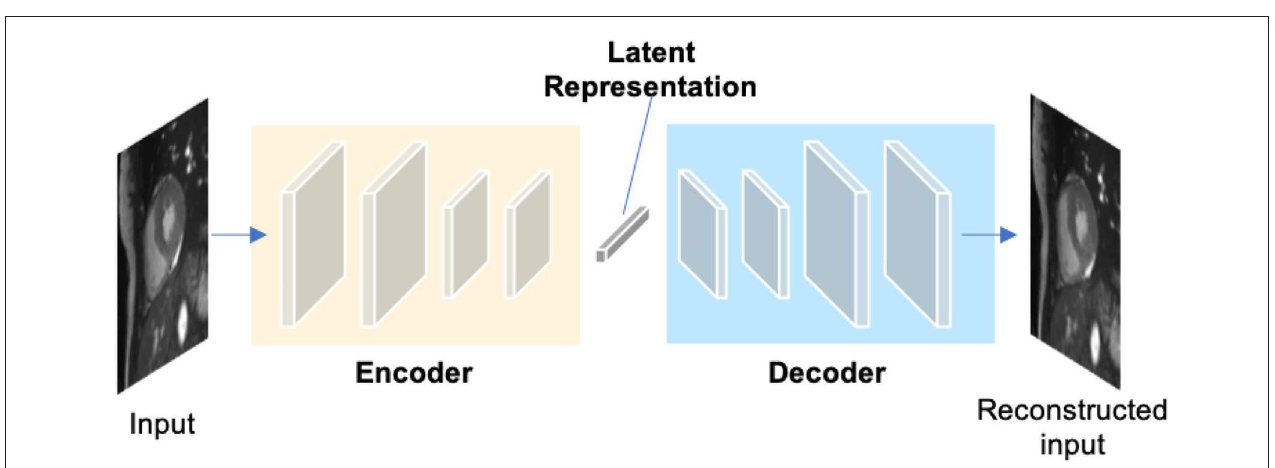
FIGURE 6 | A generic architecture of an autoencoder. An autoencoder employs an encoder-decoder structure, where the encoder maps the input data to a low-dimensional latent representation and the decoder interprets the code and reconstructs the input. The learned latent representation has been found effective for cardiac image segmentation (58, 59), cardiac shape modeling (60) and cardiac segmentation correction